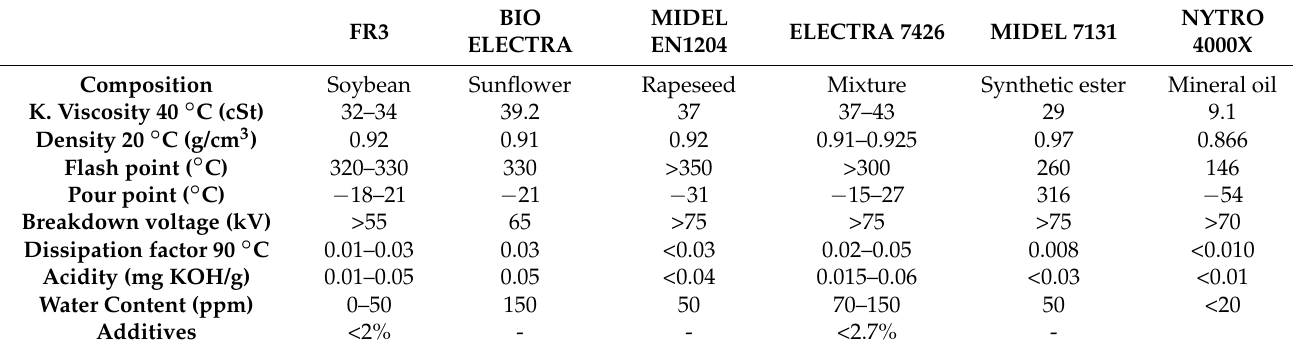
Table 4. Main properties of different commercial natural and synthetic ester fluids and mineral